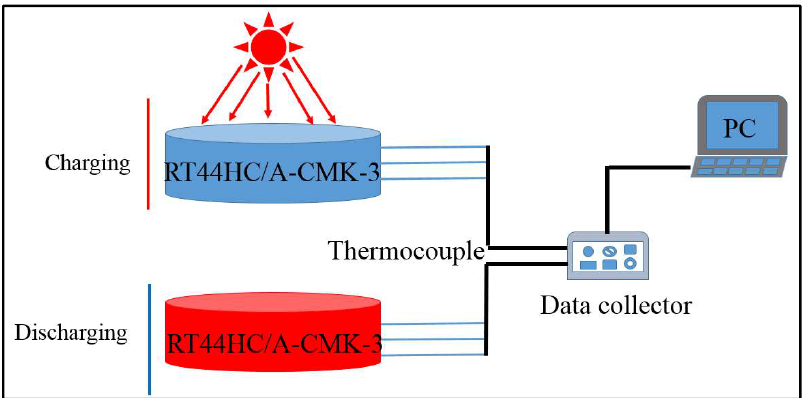
Figure 2. Photo-thermal charging and discharging performance of A-CMK-3 based phase change material (PCM).